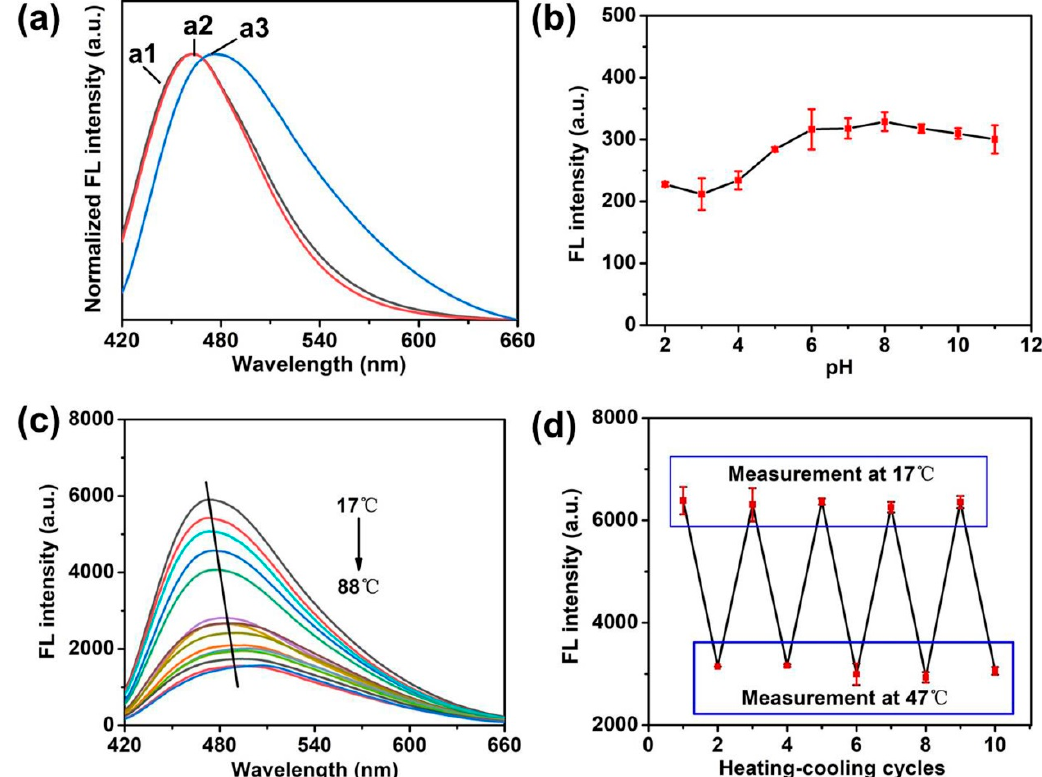
Figure 3. ( a ) The emission spectra of Si NCs (a1), Si NCs-FA (a2) and Si NCs-FA-PNIPAAm (a3). ( b ) Dependence of the fluorescence intensity of Si NCs-PNIAAm on surrounding pH values.